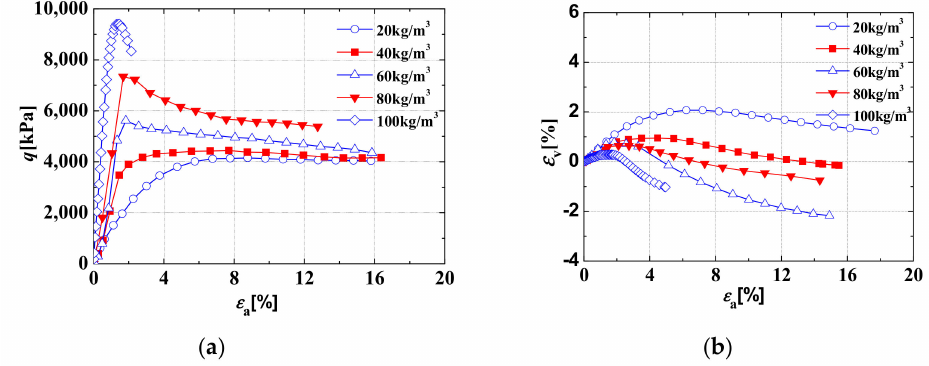
Figure 3. The curves of the triaxial tests for CSG material with the confining pressure of 900 kPa: ( a ) the stress–strain curves; ( b ) the volumetric strain-axial strain curves.